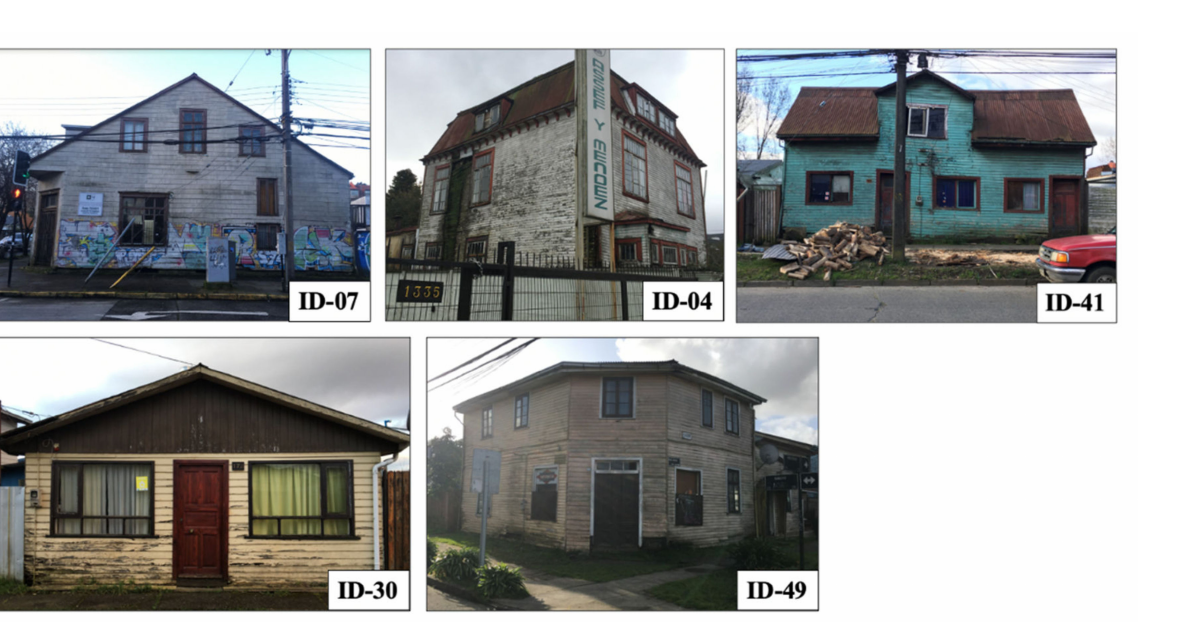
Figure 5. Five case studies (ID-07 to ID-49) that have reached the end of their physical and functional service